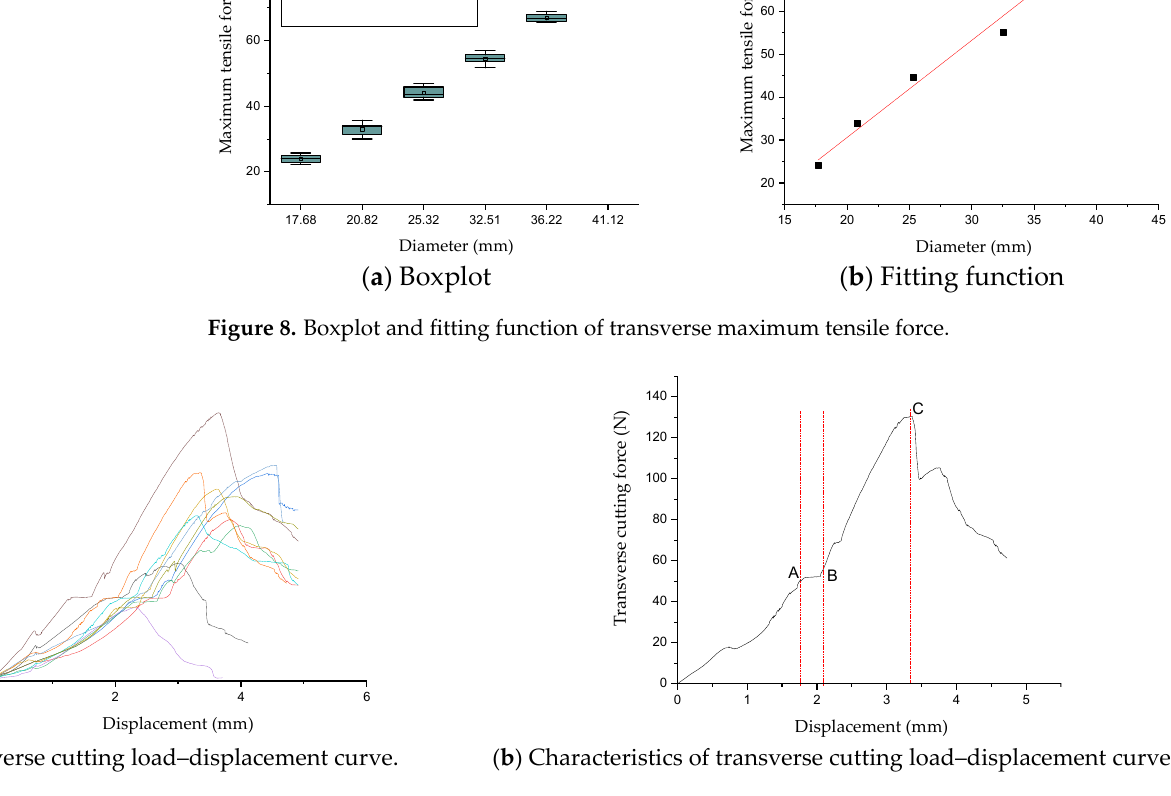
Figure 8. Boxplot and fitting function of transverse maximum tensile force.